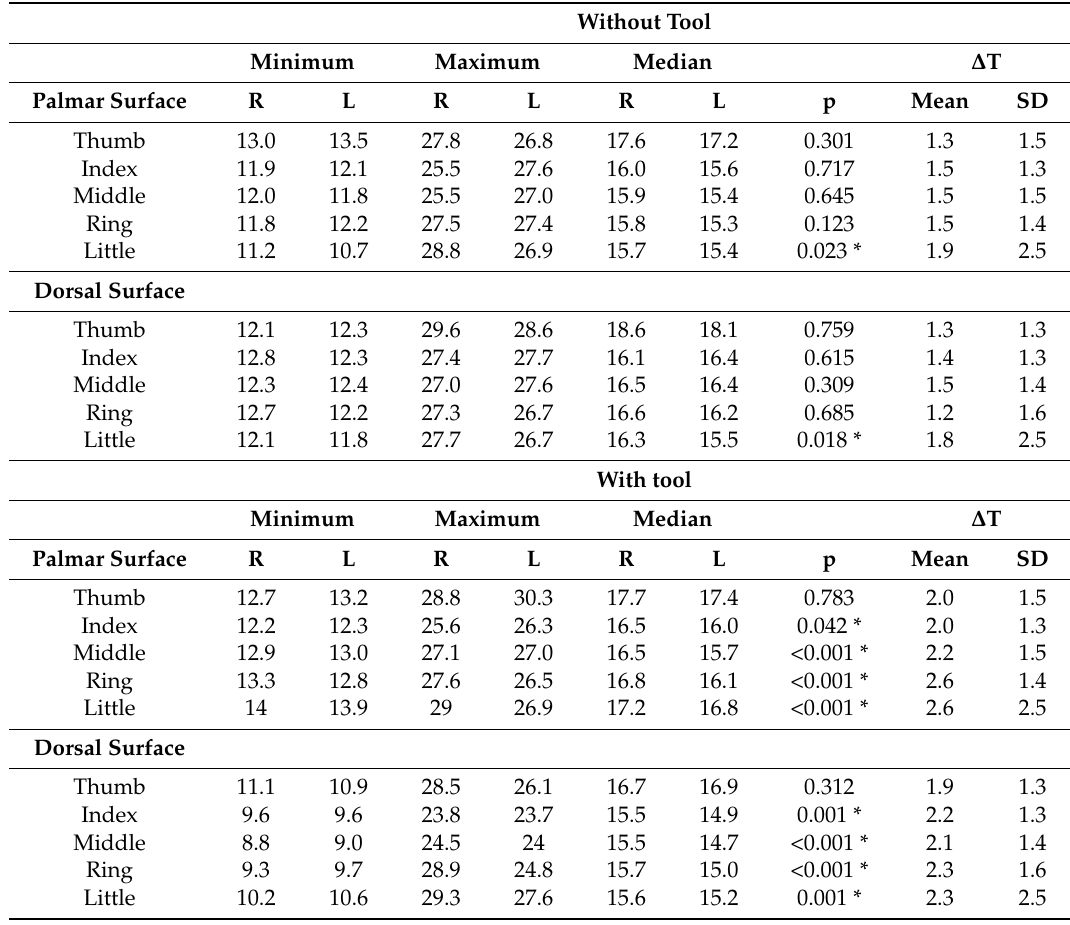
Table 2. Comparison between finger temperatures (right and left) and the use of a tool by workers. Without Tool Minimum Maximum Median ∆ T Palmar Surface